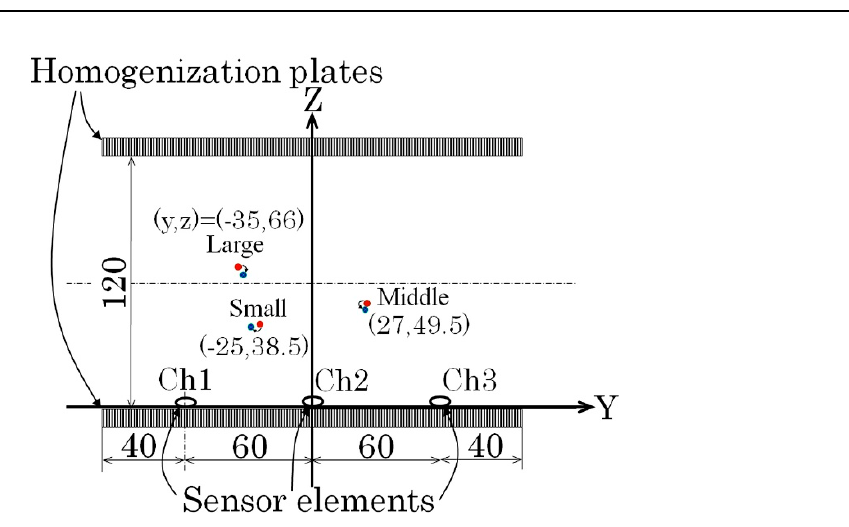
Figure 25. Estimated results for the third experiment (Red: actual position, Blue: estimation). Table 2. Results of position and magnetization estimation (Third experiment).